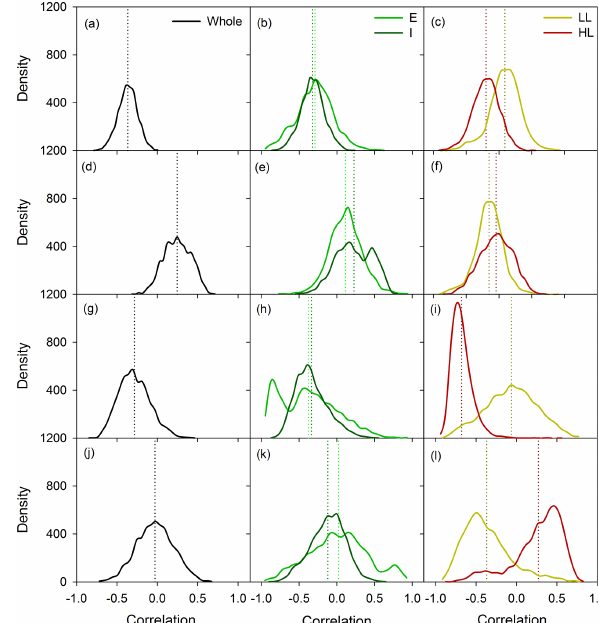
Figure 3. Density distribution of the bootstrapped correlation coef- ficients with and without distinction between successional stages (E, early; I, intermediate) and relative liana abundance (LL, low liana abundance; HL, high liana abundance). Panels (a) , (b) , and (c) correspond to the correlation of canopy openness and the ratio of liana basal area to total basal area (L/TBA); (d) , (e) , (f) correspond to leaf area index-L/TBA correlation; (g) , (h) , and (i) correspond to the maximum tree height to TBA correlation; (j) , (k) , and (l) corre- spond to plant area volume density to TBA correlation. Each dotted line represents the mean value of the bootstrapped